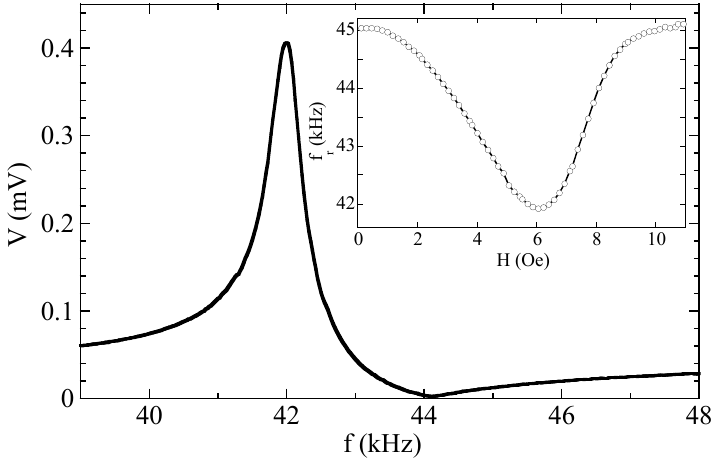
Figure 7. Magnetoelastic resonance of an amorphous ribbon. The inset shows the dependence of the resonant frequency on the applied magnetic